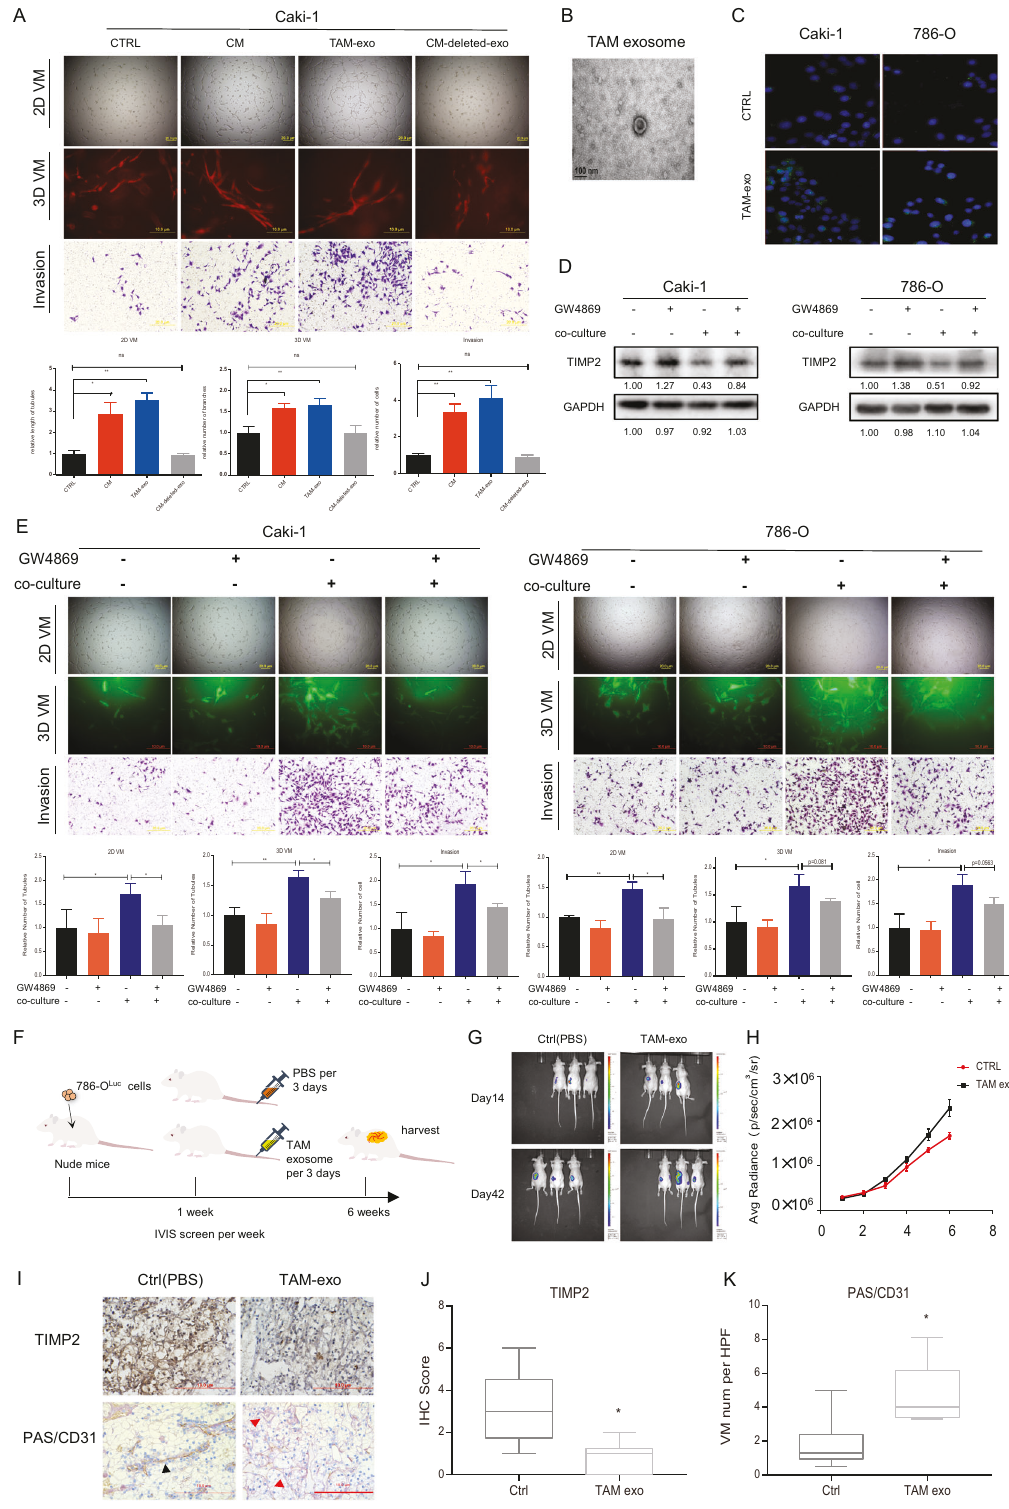
region to initiate its transcription (Fig. 5O). Based on the ChIP results, we constructed a pGL3-luciferase plasmid including the WT miR-193a promoter or the MT promoter, which had mutations in the key sequence of HRE2 (Fig. 5P). Following transfection of the constructed plasmids into macrophages with